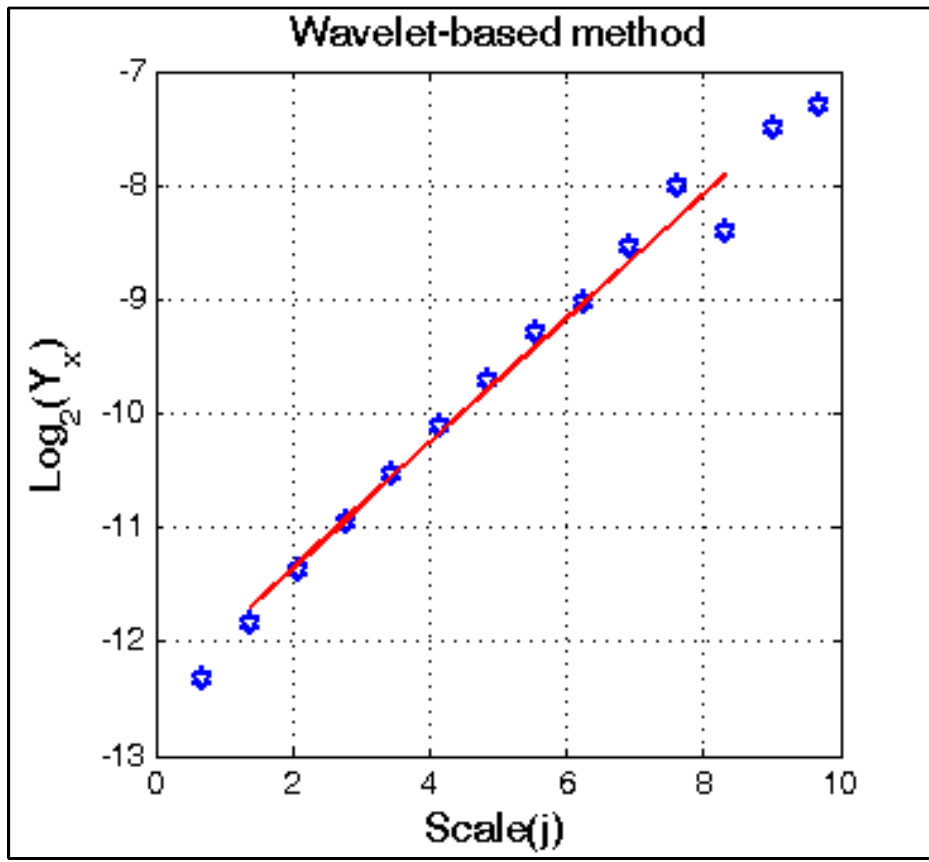
Figure 2. Wavelet-based method for determining the Hurst exponent .